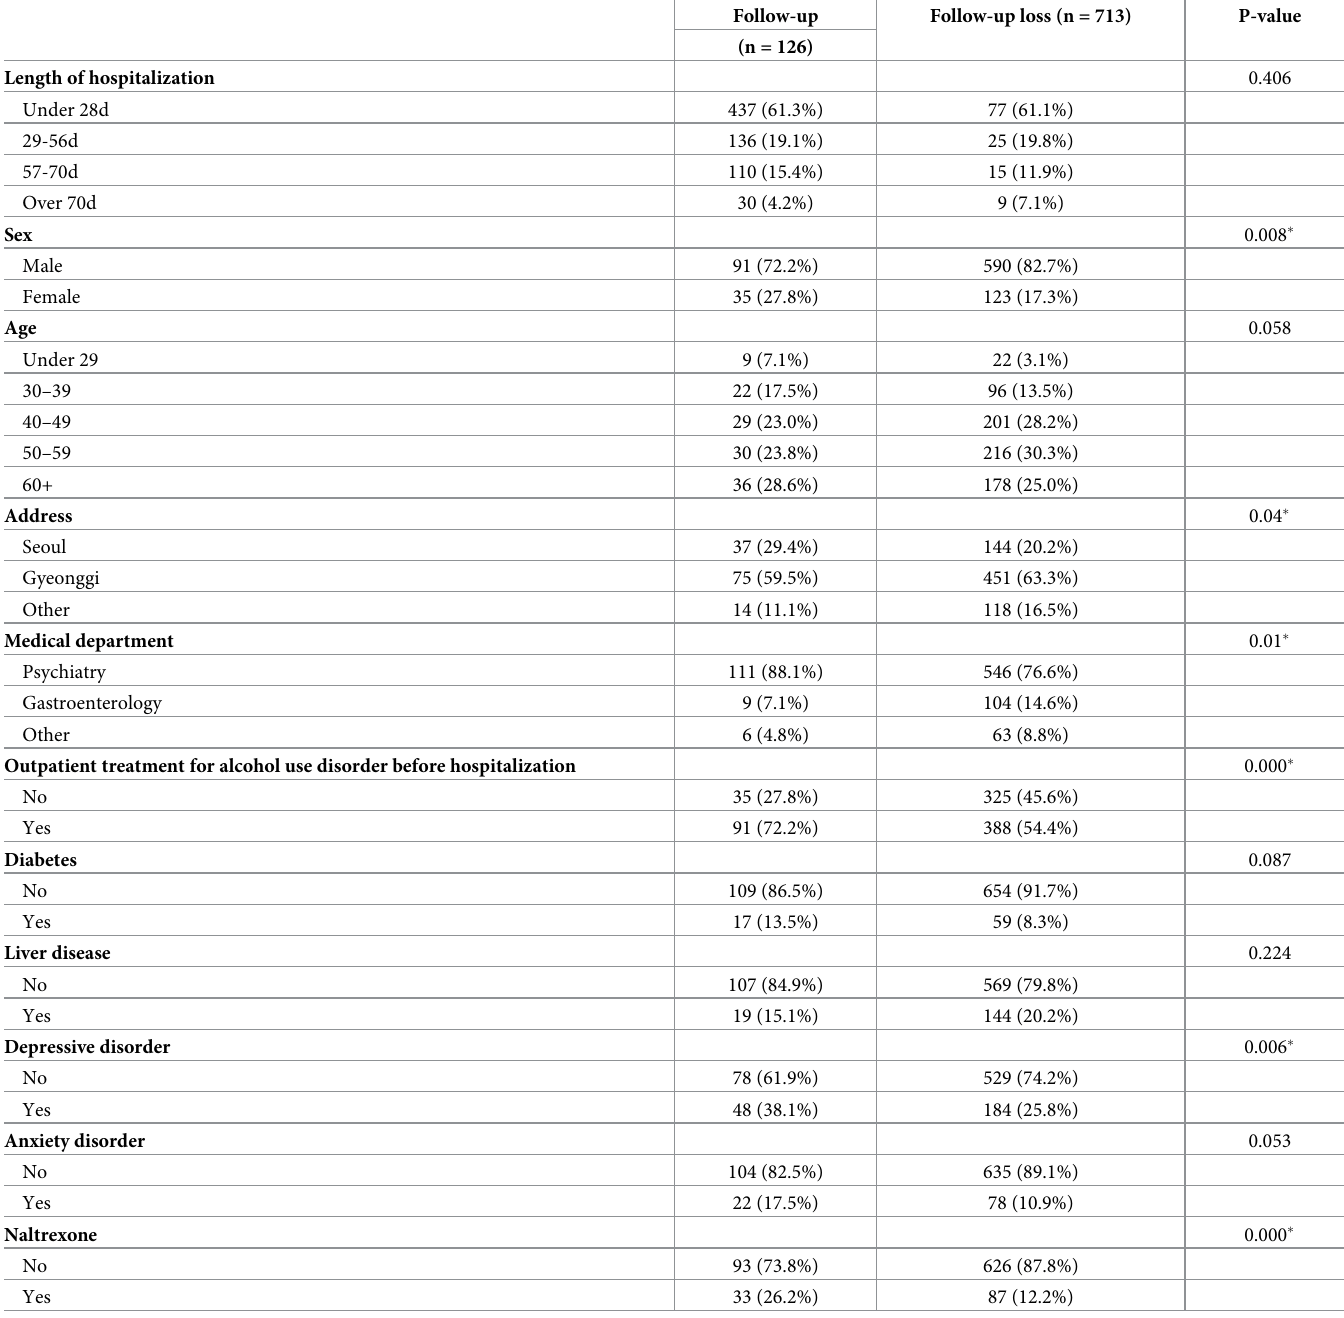
Table 1. Patient